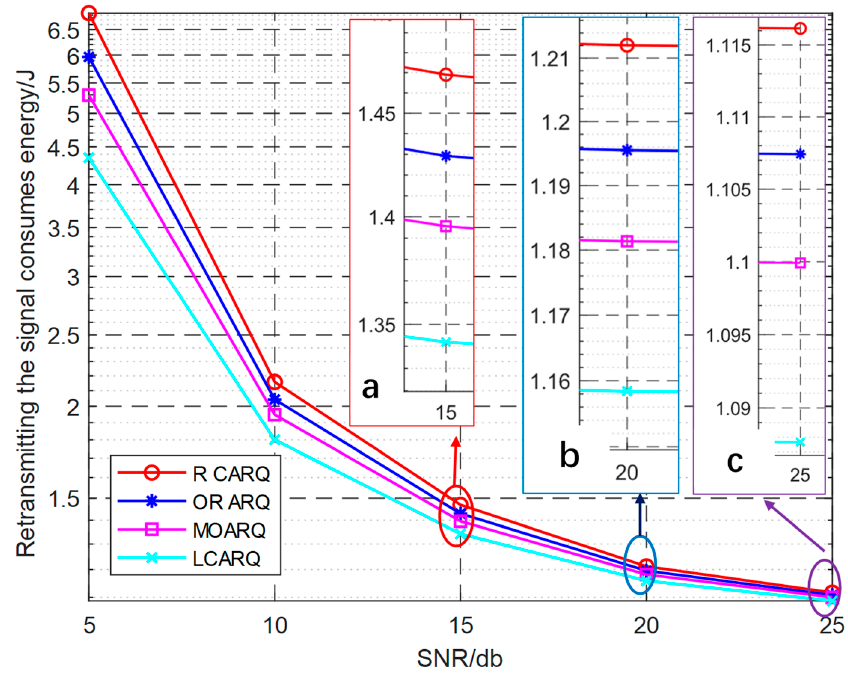
Figure 6. Comparison of the energy consumption of the retransmission process for different algo- rithms. rithms. ( a ) Residual energy comparison with SNR of 15 db. ( b ) Residual energy comparison with SNR of 20 db. ( c ) Residual energy comparison with SNR of 25